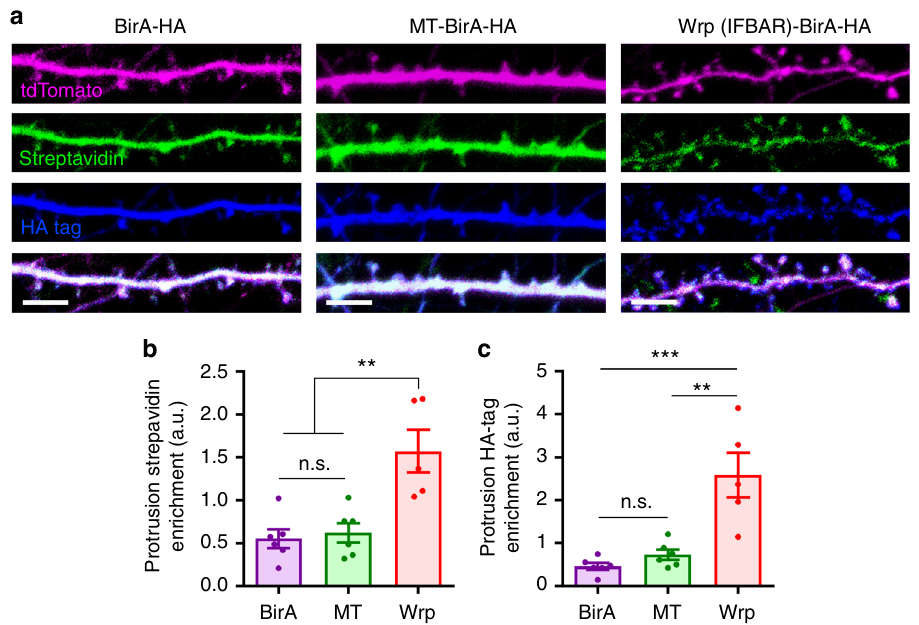
Fig. 1 Wrp-BirA localizes to and biotinylates proteins within nascent dendritic spines. a Representative images of cultured neurons expressing either BirA (Control), Membrane-Tag-BirA (MT-BirA), or Wrp(IFBAR)-BirA (Wrp-BirA). Co-transfected tandem dimer Tomato fl uorescent protein (tdTomato 67 ) fi ll is shown in magenta, streptavidin staining is shown in green, and the HA tag for each construct is shown in blue. Scale bars are 5 μ m. b Graph depicting streptavidin enrichment in dendritic protrusions vs the dendrite for each BirA (0.555 ± 0.110 spine intensity: dendrite intensity, n = 6 neurons), MT-BirA (0.622 ± 0.113 spine intensity: dendrite intensity, n = 6 neurons), and Wrp-BirA (1.353 ± 0.300 spine intensity: dendrite intensity, n = 6 neurons). F = 5.138, p = 0.020. c Graph depicting streptavidin enrichment in dendritic protrusions vs the dendrite for BirA (0.465 ± 0.080 spine intensity: dendrite 2,15 intensity, n = 6 neurons), MT-BirA (0.732 ± 0.118 spine intensity: dendrite intensity, n = 6 neurons), and Wrp-BirA (2.269 ± 0.530 spine intensity: dendrite intensity, n = 5 neurons). F 2,8.591 = 6.452, p = 0.019. Error bars are standard error of the mean (SEM). * p <0.05; ** p <0.01, one-way